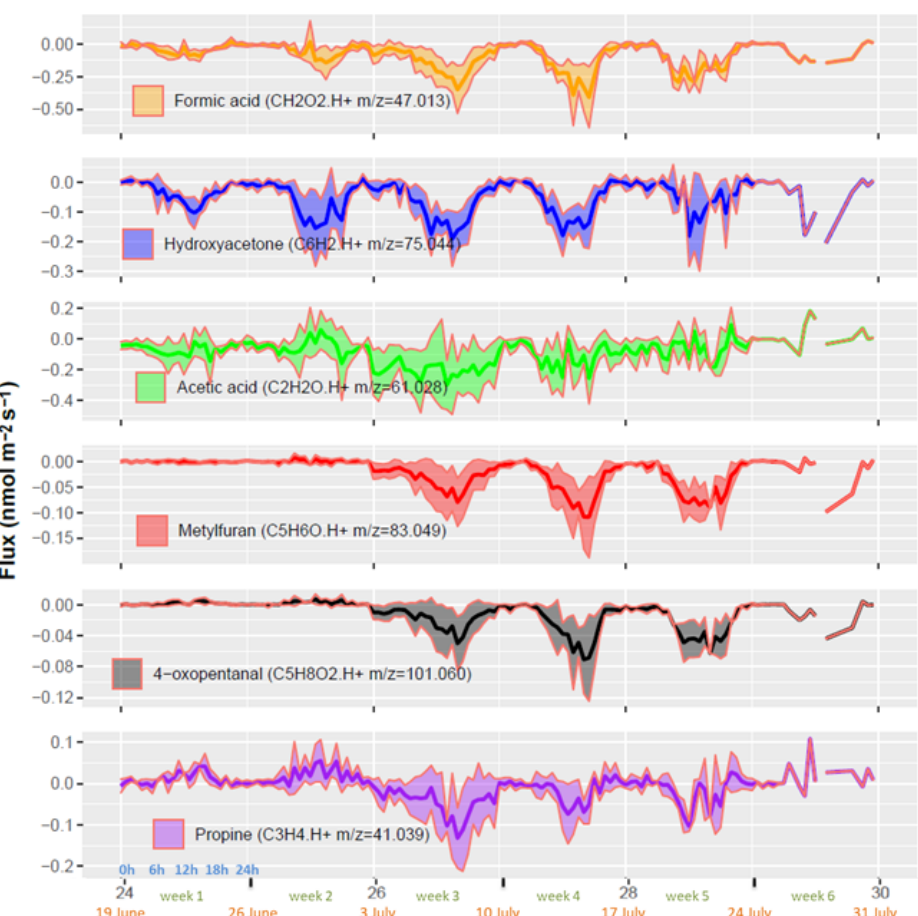
Figure 6. Whole ecosystem fluxes of the six most deposited VOCs. Each week shows the diel cycle with its mean (line) and standard deviation (ribbons). The x axis shows the week number in the year (black), the week number in the experiment (green), the starting date of the week (orange) and the hour of day (blue). Only 1d of measurement was available during week 6, leading to no interquartile computation and hence no